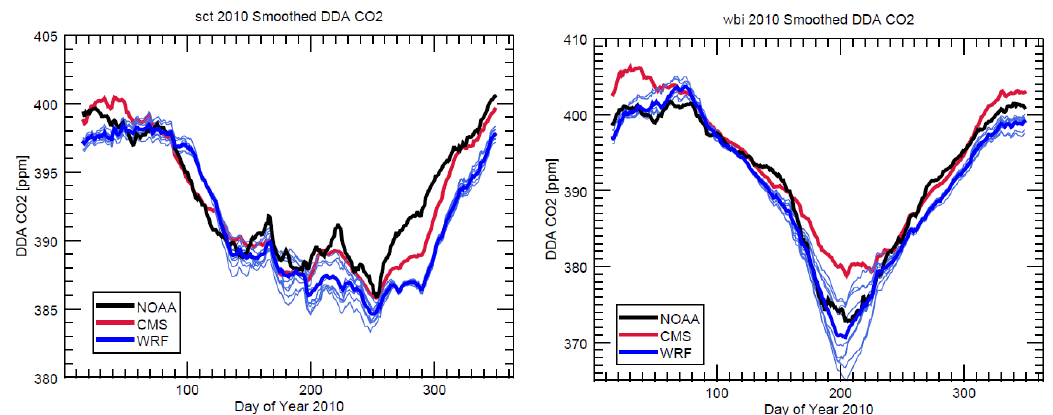
Figure 12. Comparison of 31-day running mean of daytime daily values of modeled and observed CO 2 mole fractions (in ppm) near West Branch, Iowa (WBI) and Beech Island, South Carolina (SCT) NOAA tall towers from the CMS-Flux model (in red), the WRF transport ensemble (in blue), and the observed CO 2 mole fractions (in black) for the year